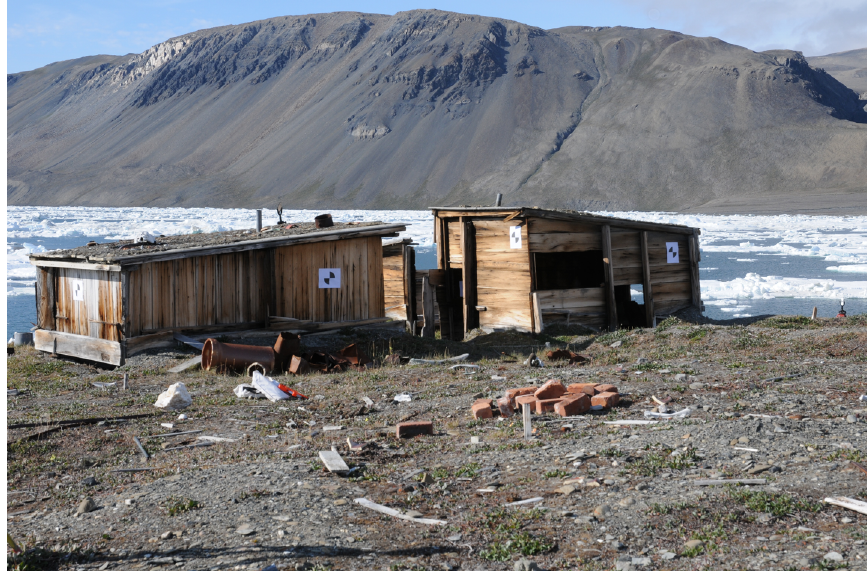
Figure 2. Photograph of Fort Conger as it appeared in